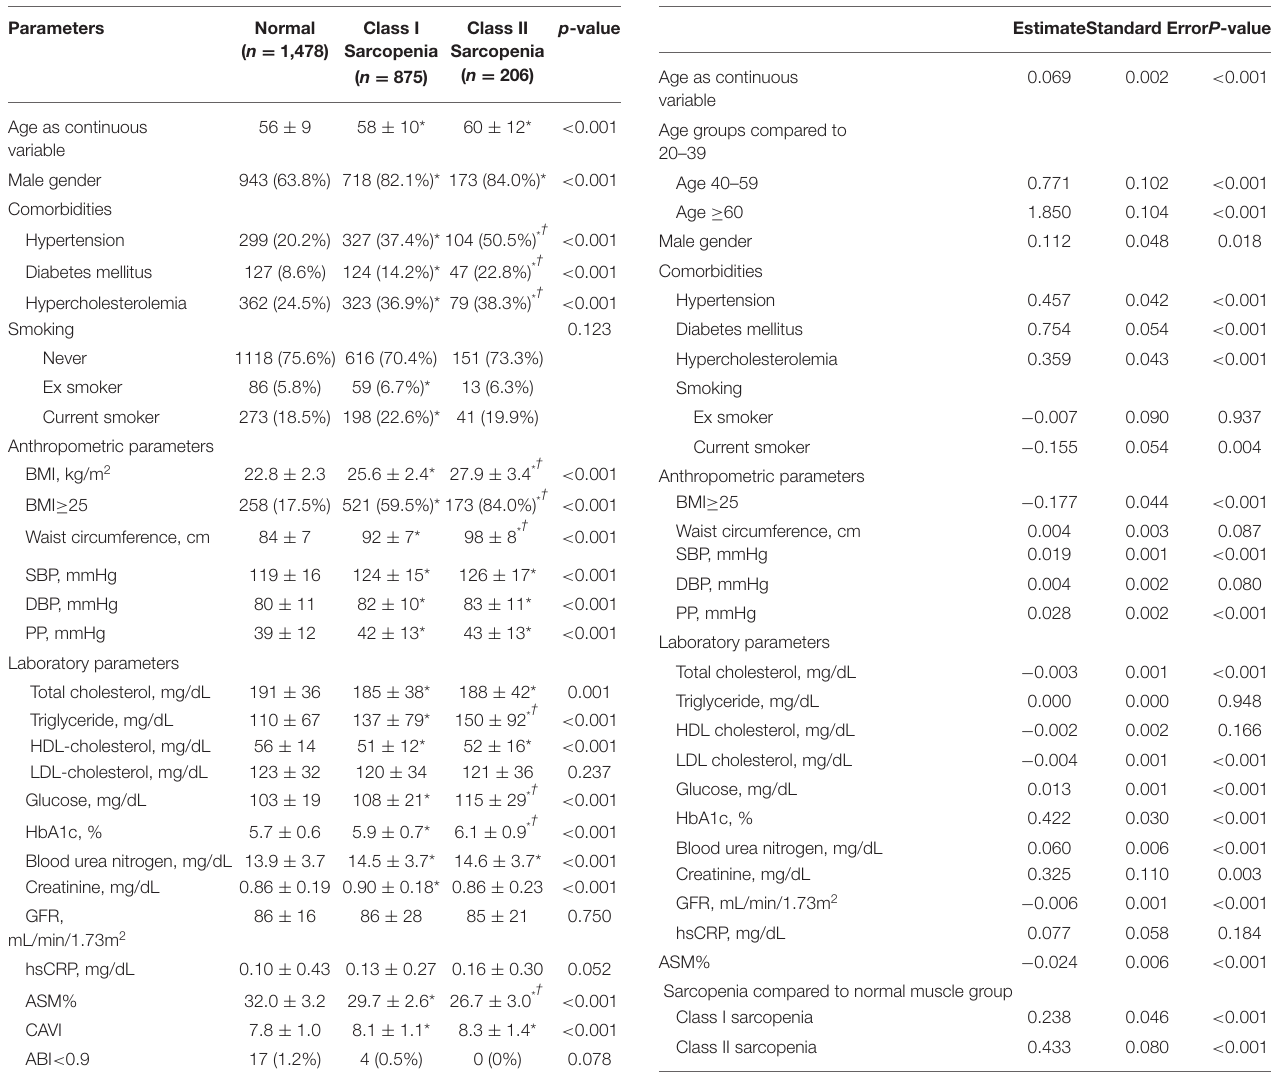
TABLE 1 | Baseline characteristics of the study subjects. TABLE 2 | The association of parameters in association with arterial stiffness.